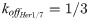
Quantification of delay in expression between her1 gene copies in a PSM cell.4A: Schematic of quantification. Oscillatory gene expression in the posterior of the PSM is shown in cyan. The PSM is divided into intervals in order to quantify this gene expression, spatially. 4B: A single slice of a zebrafish embryo with nuclei in magenta and her1 mRNA in cyan. 4C: The zoomed in square of 4B to closer demonstrate the cytoplasmic her1 mRNA molecules and her1 transcripts in the course of synthesis. In both figures, the cyan stripes of her1 mRNA are apparent. Intervals are overlaid, based on the gradient of the her1 mRNA waves, and the frequency of nuclei with one her1 transcript in the course of synthesis and those with two is quantified per interval. 4Ci: A cell containing cytoplasmic her1 mRNA molecules. 4Cii: A cell with one her1 gene copy expressed. 4Ciii: A cell with two her1 gene copies expressed. 4D: Plot of frequency of nuclei with one dot (blue) and frequency with two dots (red) per interval. The two dot signal is delayed behind the one dot signal. 4E: The signals smoothed and the interval scale transformed to distance over the anterior axis (scaled from zero to one). The large black circles demonstrate the inflection points used to calculate the delay. This specific delay is selected as the increase in frequency of active her1 genes is a reflection of the repressing Her1/7 protein dissociating from the gene. The smaller symbol, between the two circles, gives the x coordinate used for further calculation in each case. 4F: Further example of smoothed dot count signals for an additional embryo. 4G: Box and whisker plot of delay between one and two dot signals, as a proportion of time to make one somite (left axis) and in minutes assuming the time to make one somite is thirty minutes (right axis). The minimum and maximum are given by the whiskers, the lower quartile and upper quartile by the box. The solid red line gives the median and the dot-dash red line gives the mean. The predicted delay in expression between the two her1 gene copies in a cell is three minutes. The mathematical model predicts cells will desynchronise in 6–8 oscillations when inserting the dissociation rate, koffHer1/7=1/3 min-1, corresponding to this delay.